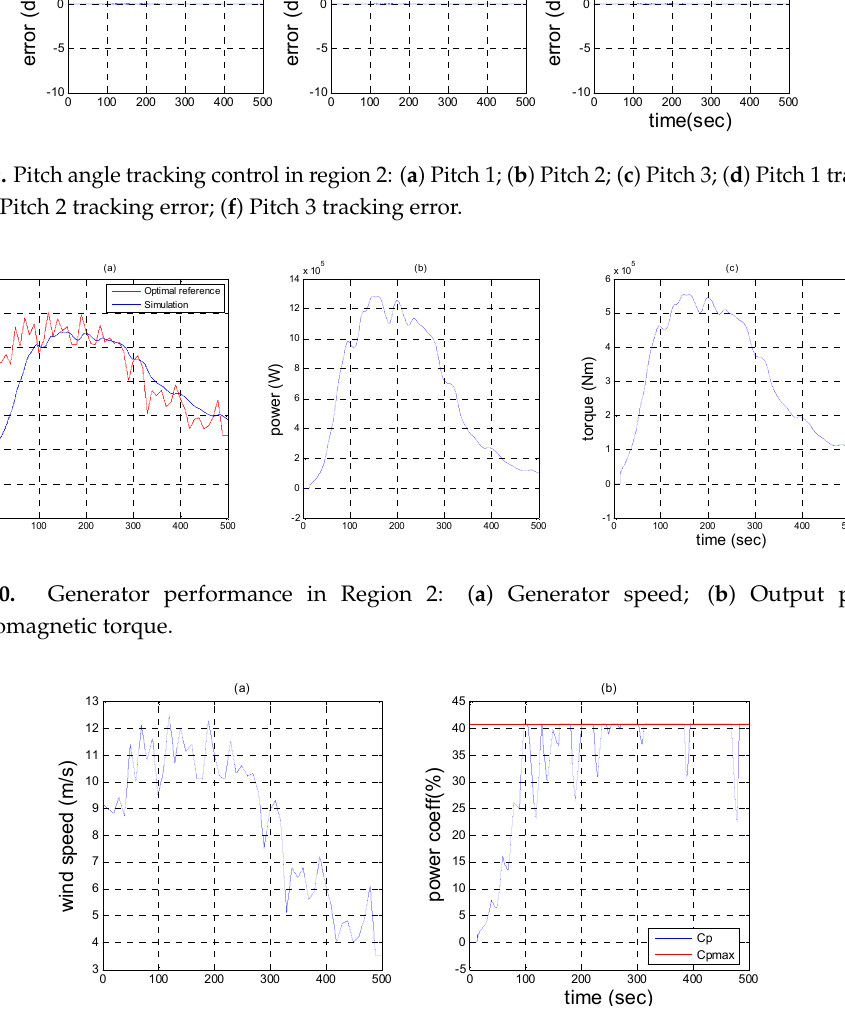
Figure 21. Wind input and overall efficiency in Region 2: ( a ) Wind input; ( b ) Overall power